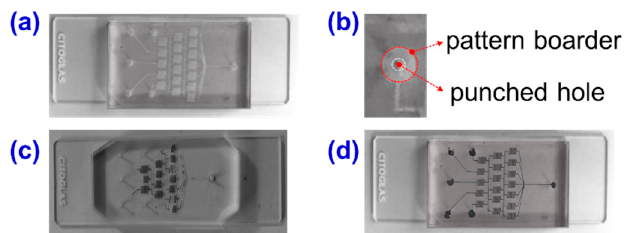
Figure 3. Effect of the inlet dimensions on the micro-casting fabrication performance. ( a ) The PDMS microchannel as the casting mold; ( b ) the appearance of the designed pattern border of the inlet and punched hole; ( c ) the microchannel failed to be filled with the melting metal with an inlet size of 1 mm; ( d ) the microchannel filled with melting metal with the inlet size of 0.6 mm.